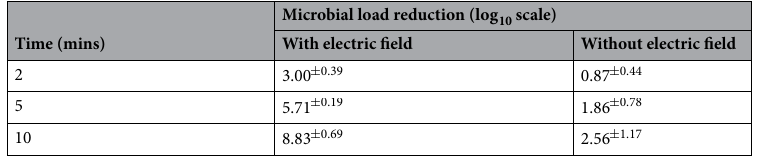
Table 2. Effect of electric field in spot experiments Effect of 3 kV/cm electric field on the log 10 -reduction in viable microbial load ( E. coli ) over the microbicidal surface in spot experiments. Superscripts show standard